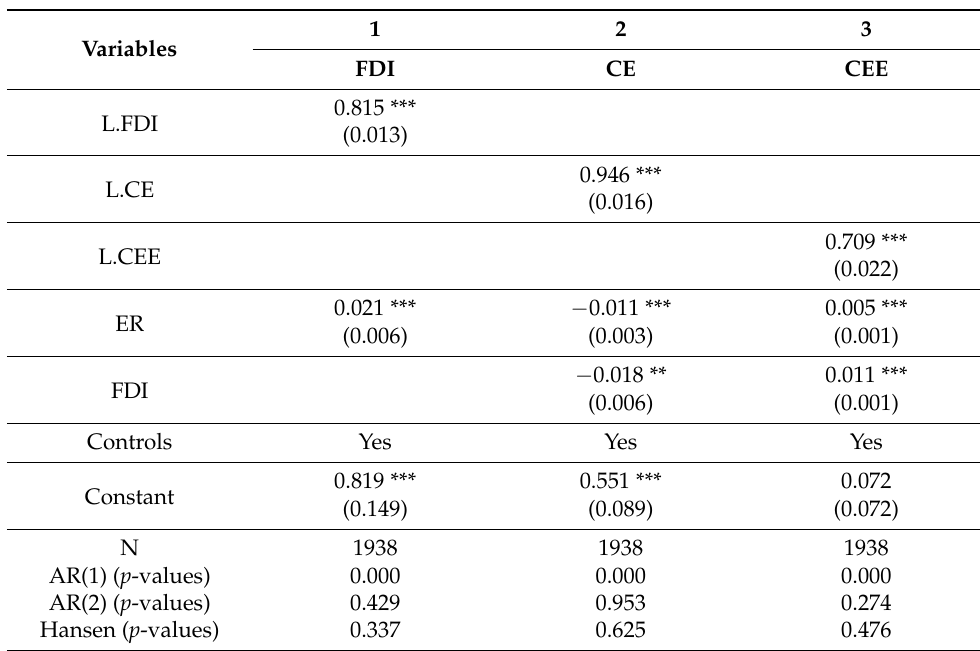
Table 5. Regression results of mechanism analysis for foreign direct